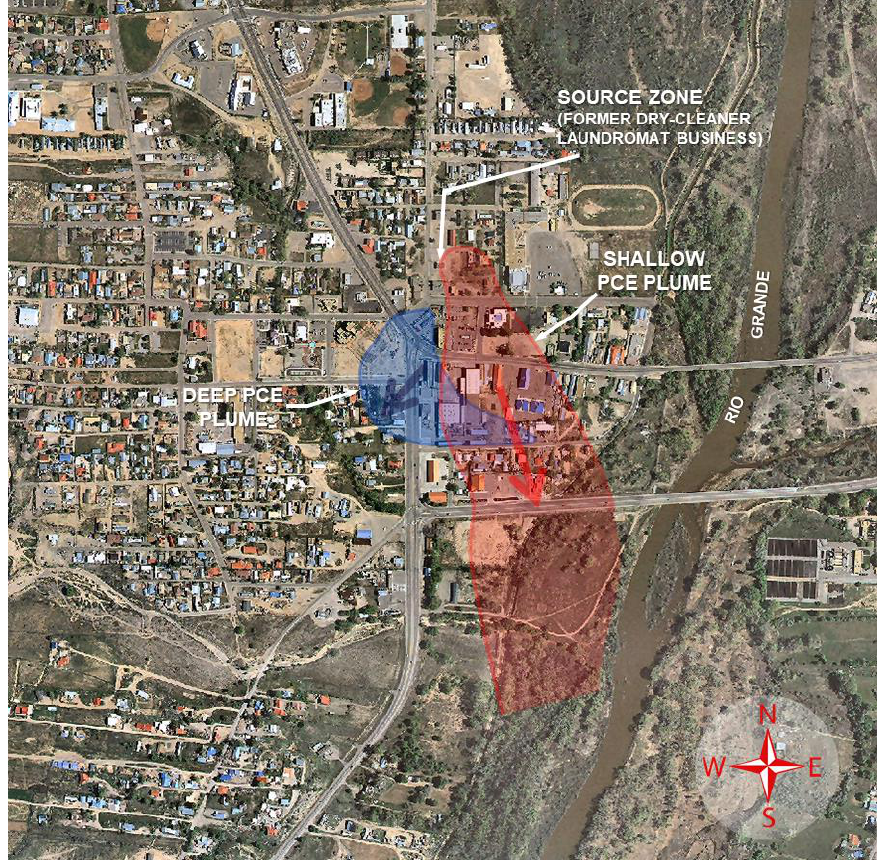
Figure 1. North Railroad Avenue Plume Superfund Site. Approximate groundwater plumes prior to remediation and the groundwater flow directions in the shallow aquifer (red plume with red arrow) and deep aquifer (blue plume and blue arrow) are shown. The location of the source of contamination, a former dry cleaner/laundromat business, is also shown.